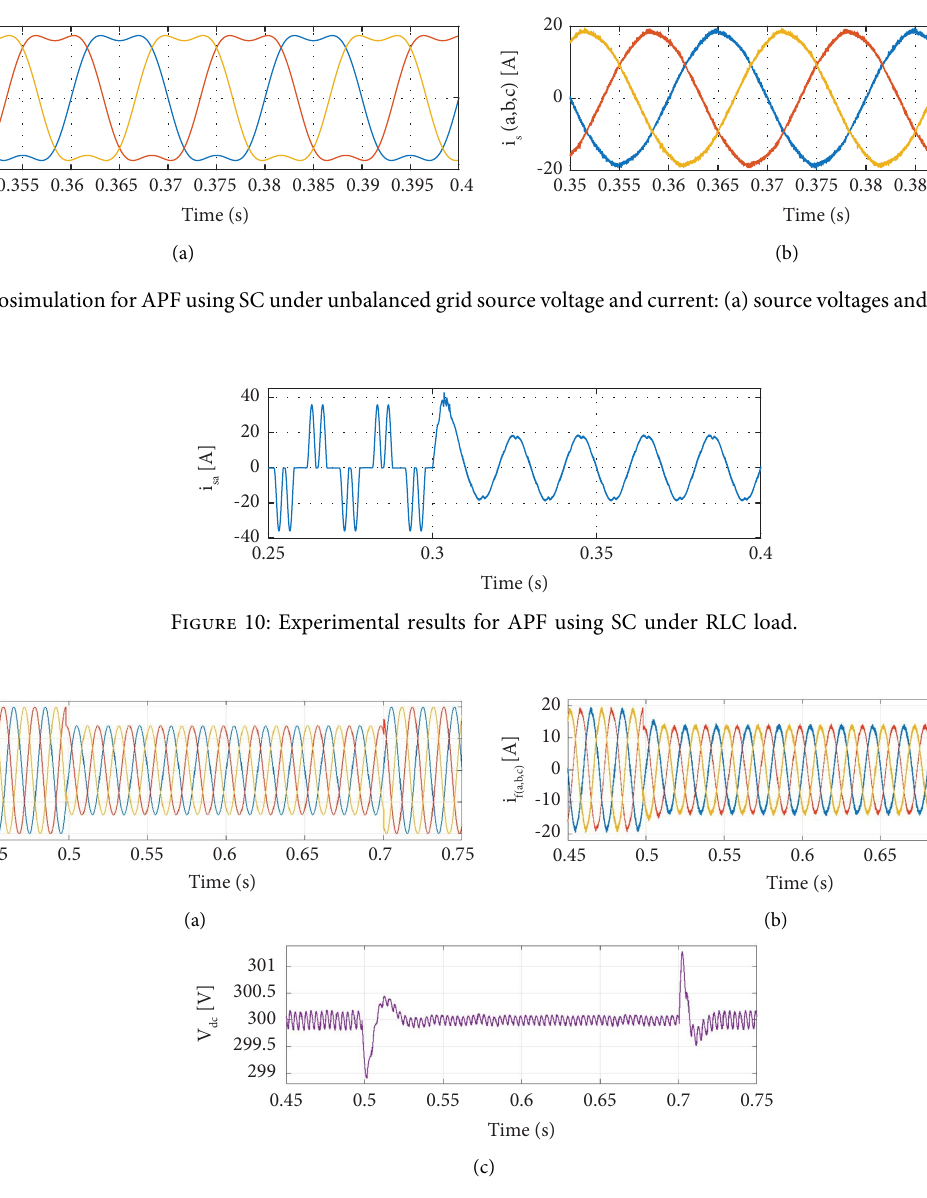
s (a), current i s (b), and voltage DC-link V dc